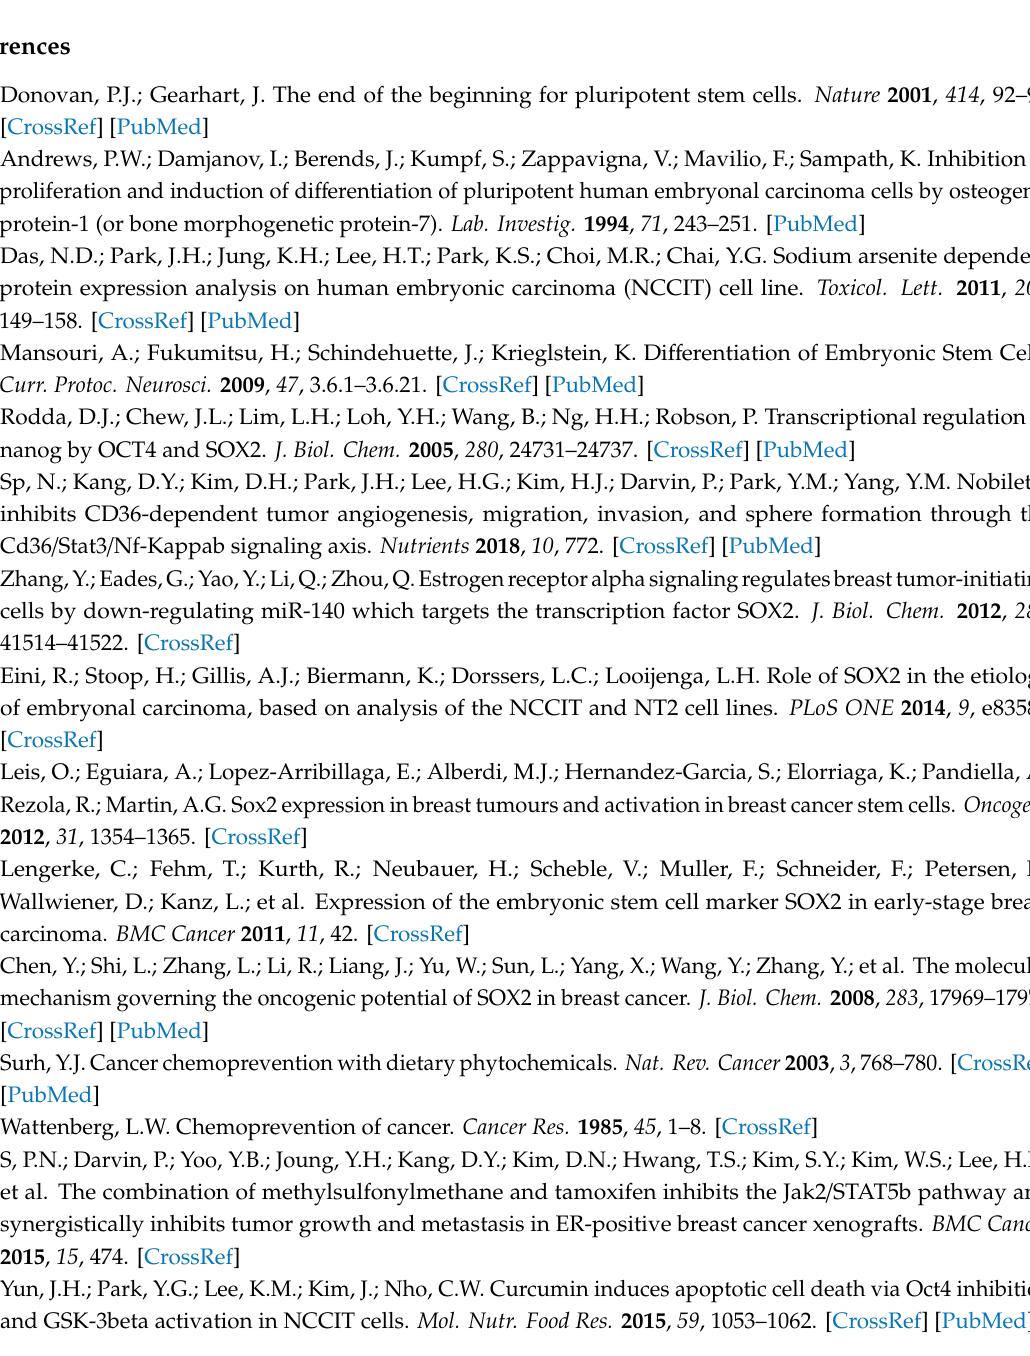
Table S1: RT-PCR primer sequences, annealing temperature, and product sizes, Table S2: q-PCR primer sequences, annealing temperature, and product